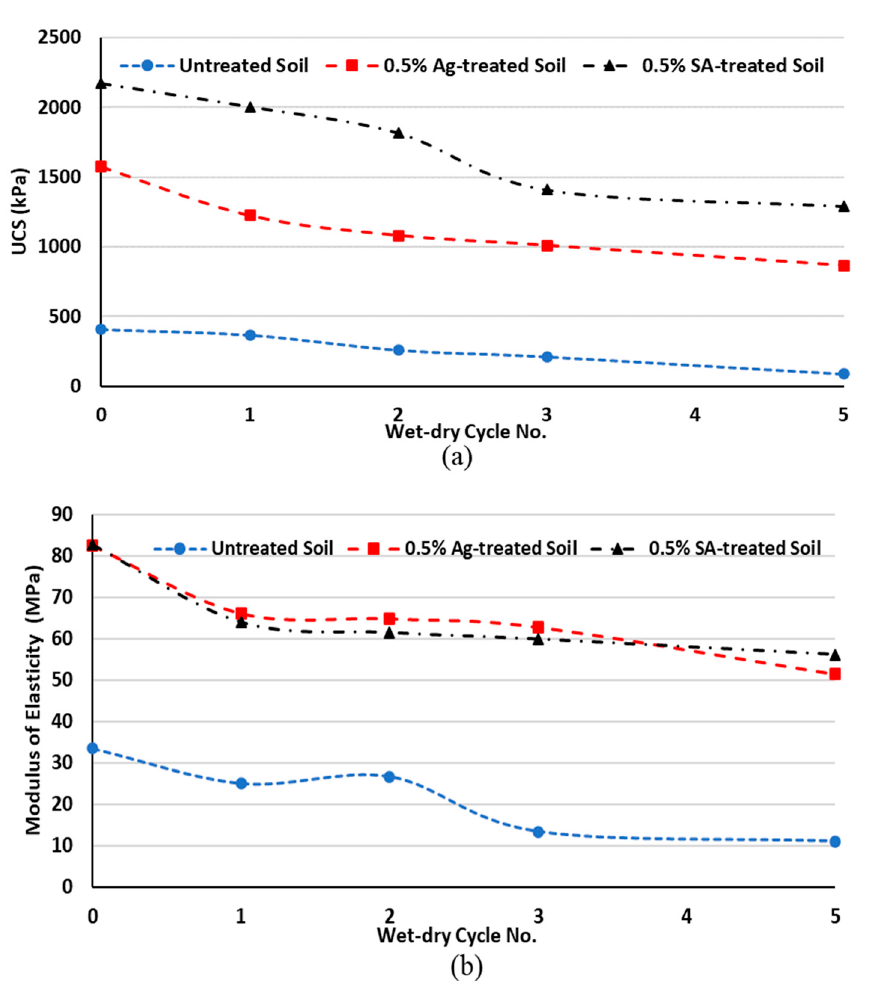
Figure 6. E ff ect of wet–dry cycles on the ( a ) UCS and ( b ) modulus of elasticity of biopolymer-treated K1S3.